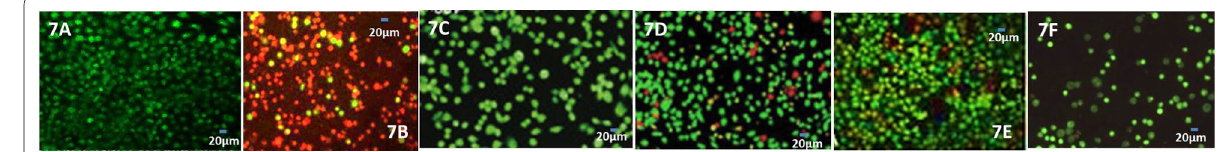
Fig. 7 Live dead assay of CNE‑2 cells on treatment with ( a ) PBS; b CuO NPs; c FOL‑PLGA‑CuO NPs; d CD‑1; e CD‑2; f CD‑3. Note the reduced cell size and huge number of dead cells in ( b ) indicating potent cytotoxic effects much reduced in other formulations